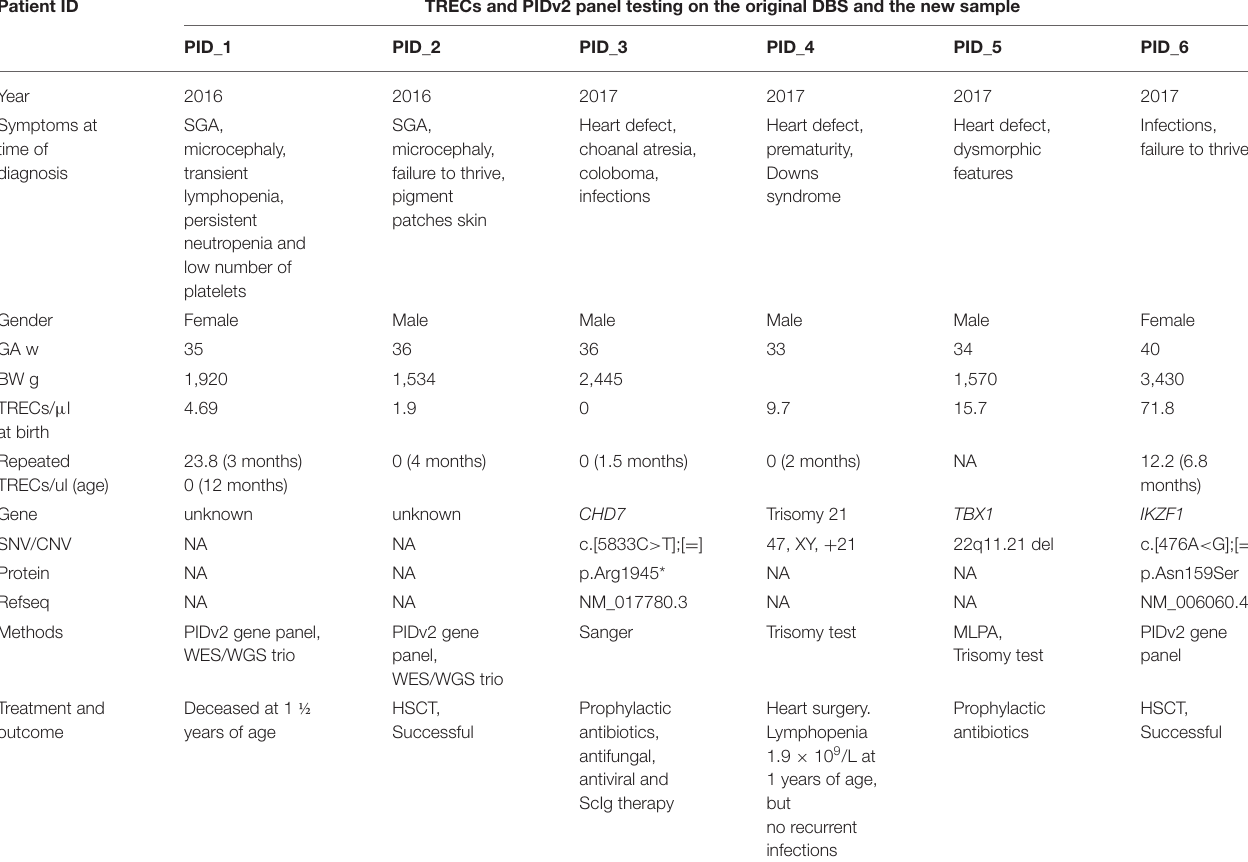
TABLE 2 | New severe PIDs, debut 3–6 months, not picked up on newborn screening since born outside pilot test region. Patient ID TRECs and PIDv2 panel testing on the original DBS and the new sample